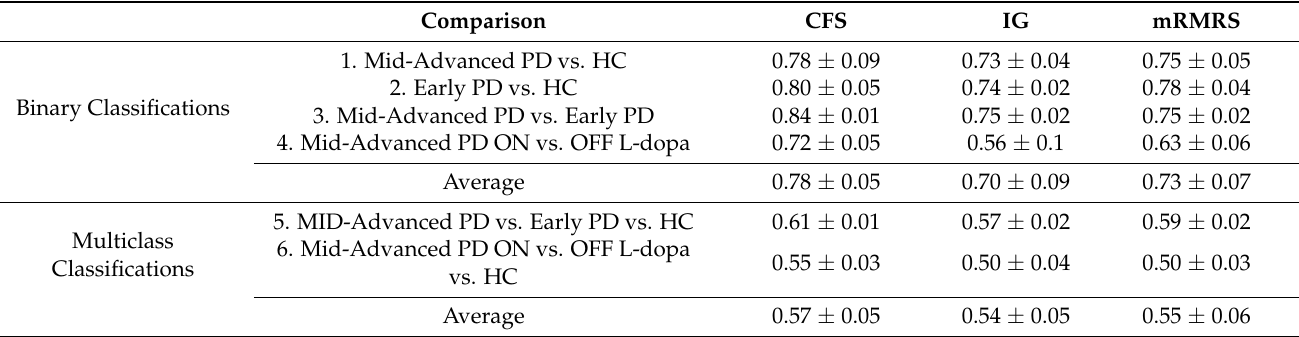
Table 4. Classification accuracy with respect to each feature selection algorithm employed. The results are expressed as the average (and standard deviation) of the CV performance yielded from KNN, NB, and SVM models. Comparison IG